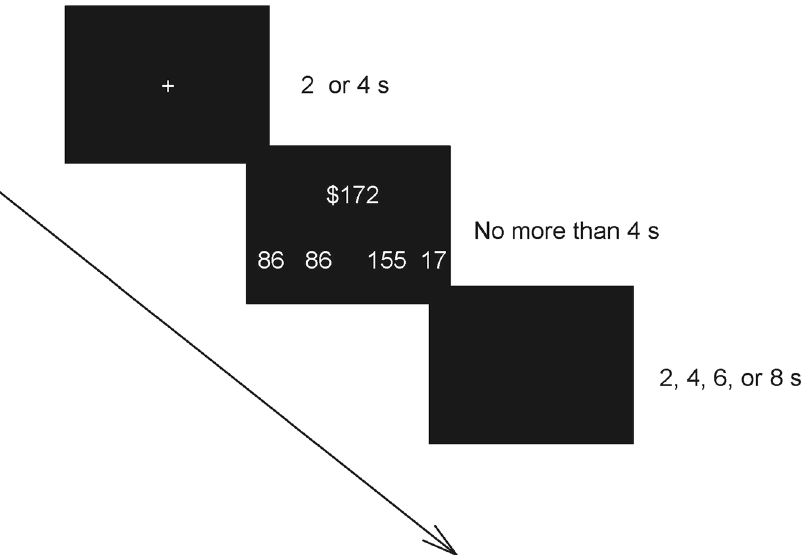
Figure 3. Timeline of an exemplar trial. In each trial, participants had to choose between a fair offer and a very selfish offer (i.e., offering 10% of the stake to the recipient) in a low